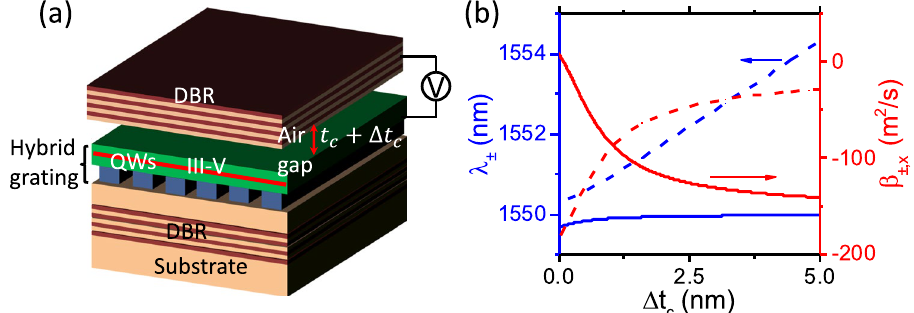
Figure 4. ( a ) Schematic view of a system of two coupled cavities consists of two outer DBRs and a hybrid grating (HG) reflector as the common mirror. ( b ) The resonance wavelength of the cavity modes λ ± (blue) and the mode dispersion curvatures in the x -direction β ± , x (red) as a function of airgap thickness detuning Δ t c for the coupled cavities of Fig. 4(a). Simulation details are provided in Supplementary